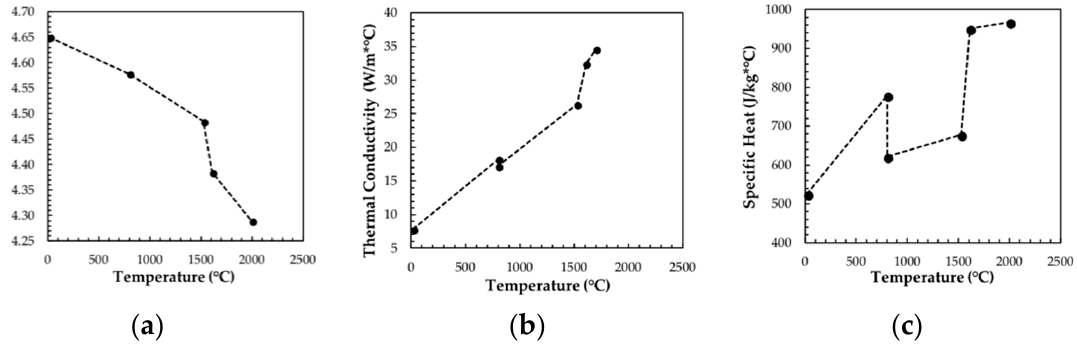
Figure 2. Graphs of estimated ( a ) density, ( b ) thermal conductivity, and ( c ) specific heat as a function of temperature for Ti-1023.